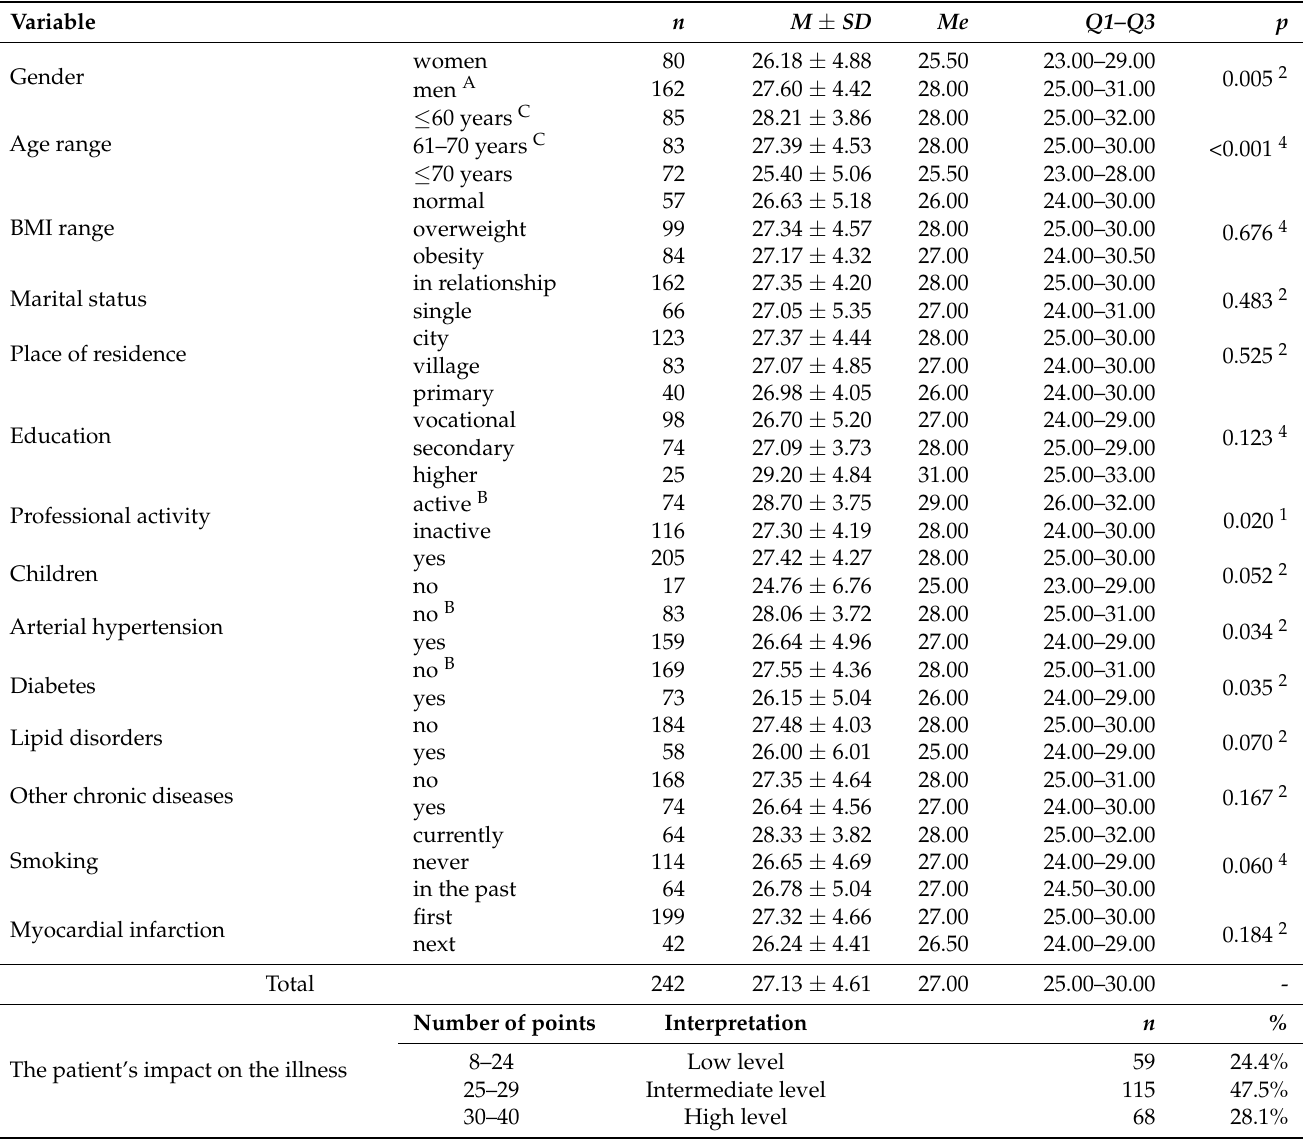
Table 4. The socio-demographic and clinical variables regarding the patient’s impact on the